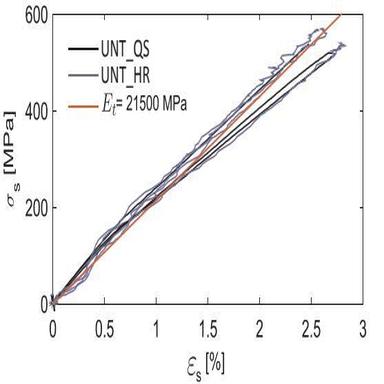
Tensile stress-strain curves in the longitudinal direction at QS and HR loading, and curve with average Young's modulus.